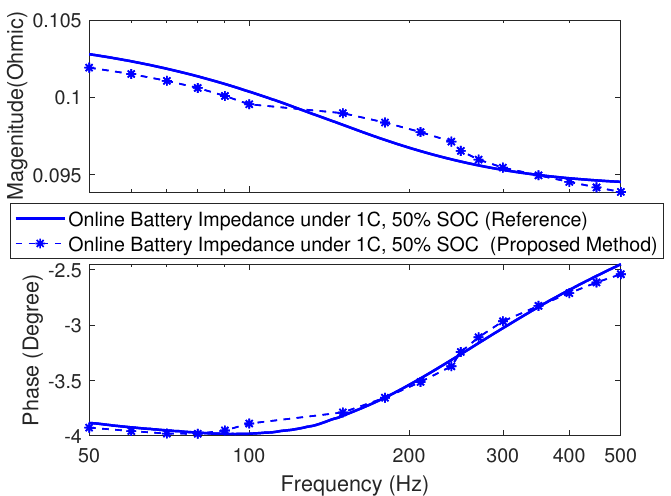
Figure 7. Online battery impedance under 50% SOC, 1C discharge current